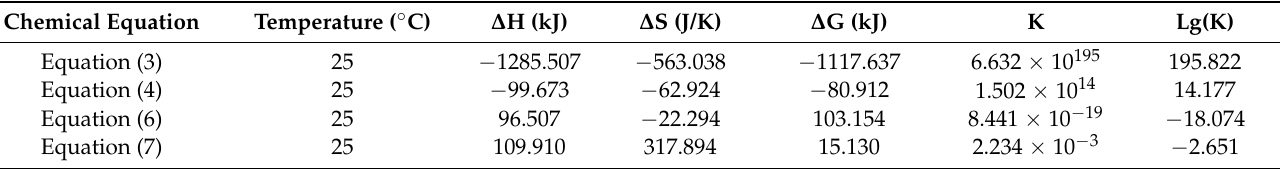
Table 4. Chemical reaction parameters during the oxidation of